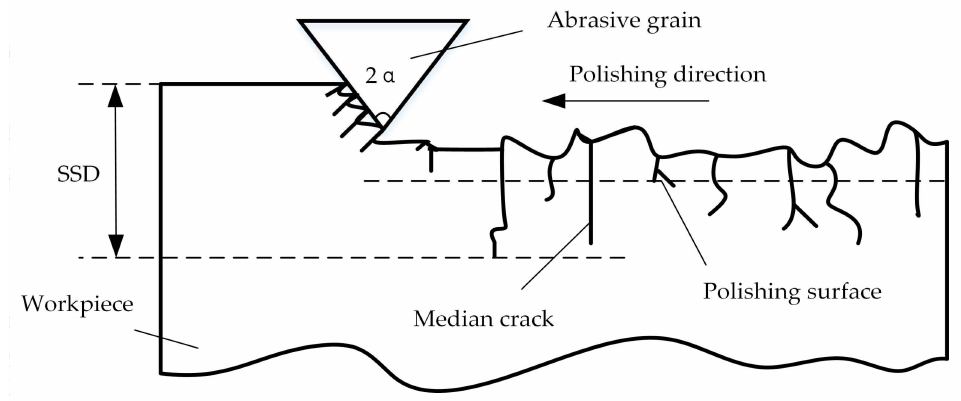
Figure 1. Scratch process of single abrasive grain.